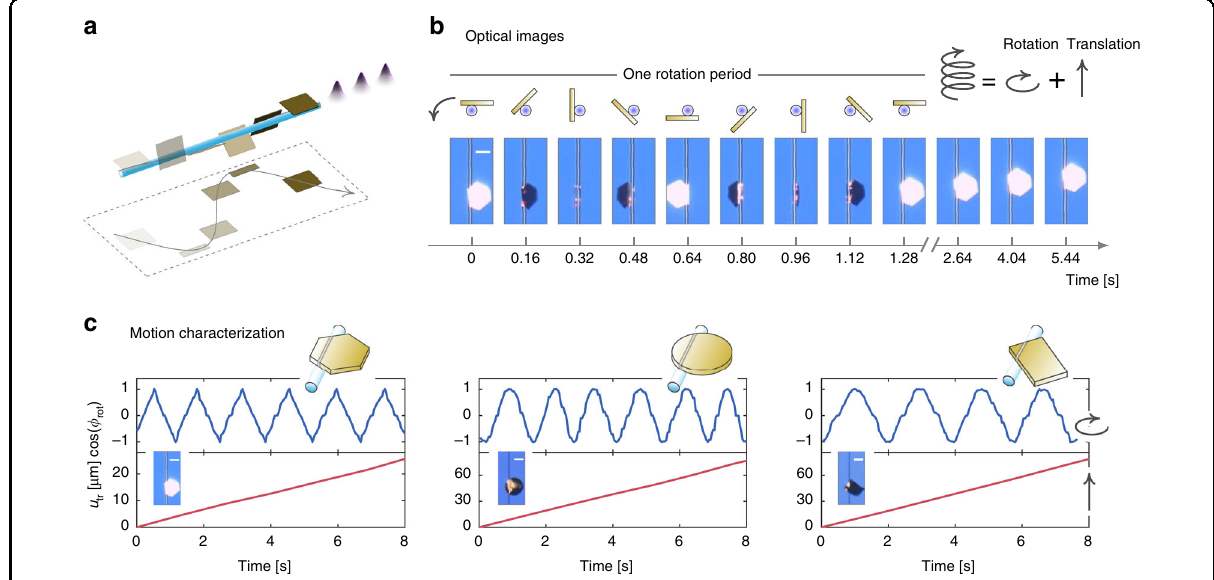
Fig. 2 Systematic measurement of spiral motion of gold plates around micro- fi bers in ambient conditions. a Sketch of the observed spiral motion. b Temporal sequencing of optical images of a hexagonal gold plate spirally moving around a micro- fi ber. The fi ber has a diameter of 2 µm, and the side length and the thickness of the plate are 27.72 µm and 30 nm, respectively. c Cosine of rotation angle Φ rot (upper panels), translation displacement (lower panels) as functions of time for gold plates with hexagonal, circular and rectangular base shapes. All scale bars represent 15 µm. The used super-continuum laser pulses have 6.8-mW average power, 2.6-ns temporal width and 6.13 – kHz repetition